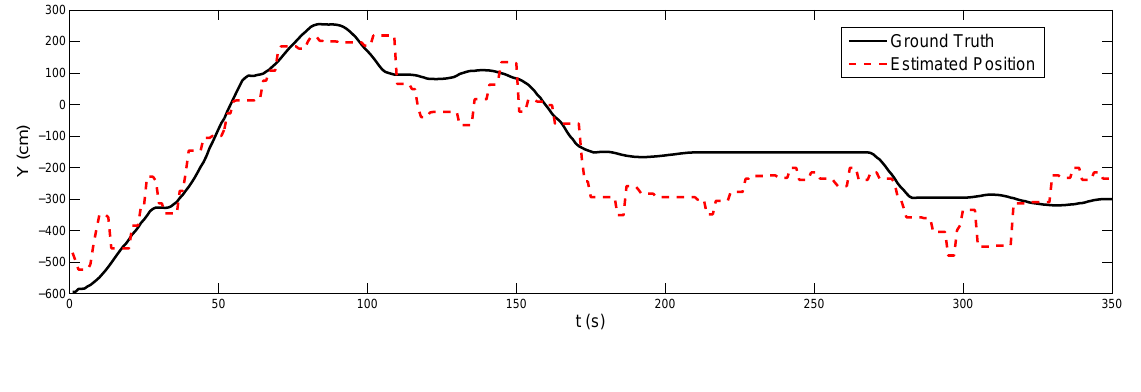
Ground Truth Estimated Position